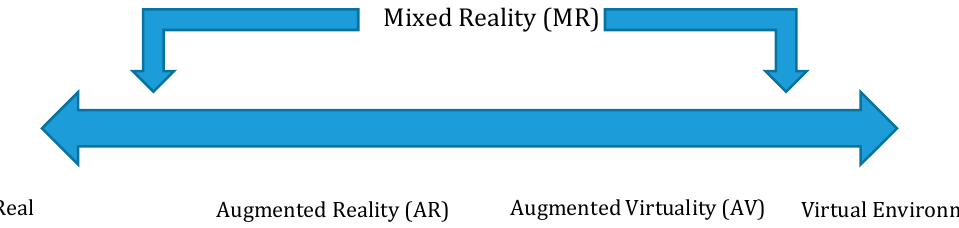
Figure 1. Reality-virtuality continuum (adapted from Milgram and Kishino (1994)